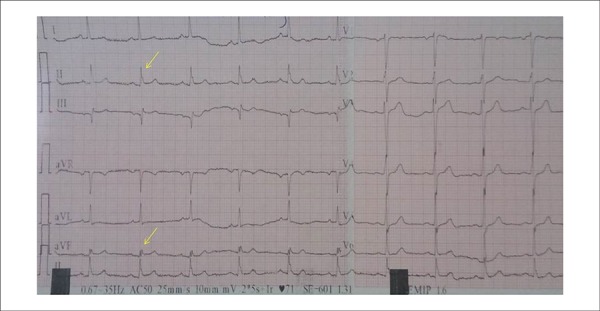
Electrocardiogram of a patient with fragmented QRS